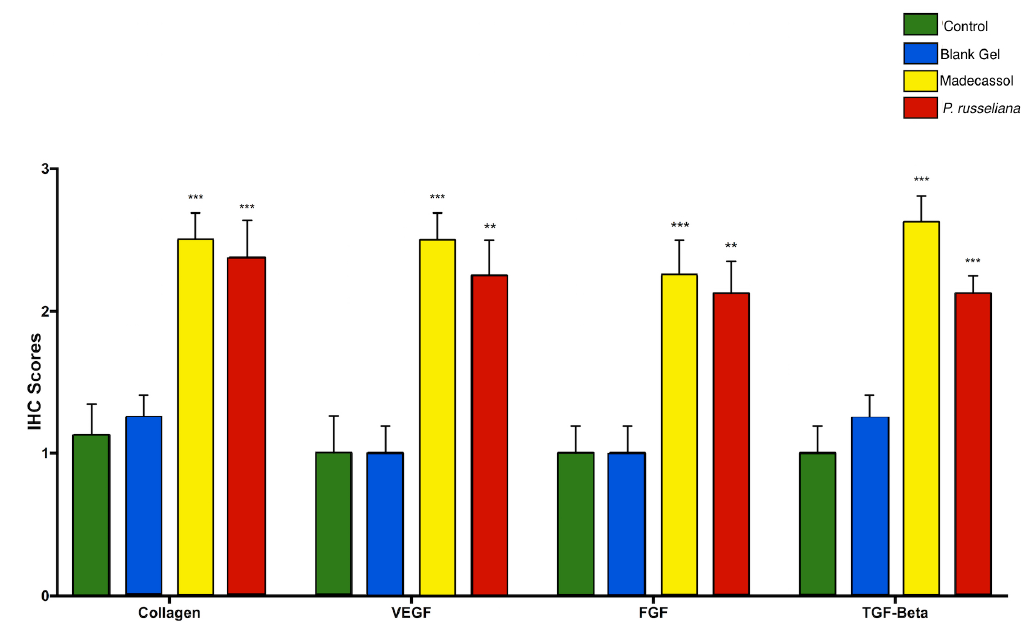
Figure 8. Comparison of immunohistochemistry; collagen, TGF-Beta, VEGf, FGF wound healing scores among the test groups. Statistically significant compared to control groups; ** p < 0.01, *** p < 0.001.